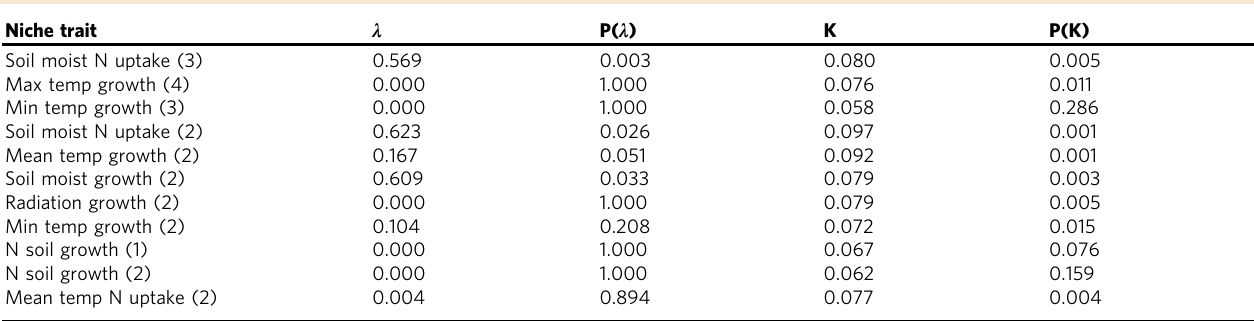
Table 2 Phylogenetic signal within Clade 7 ( Pinus ) Niche trait